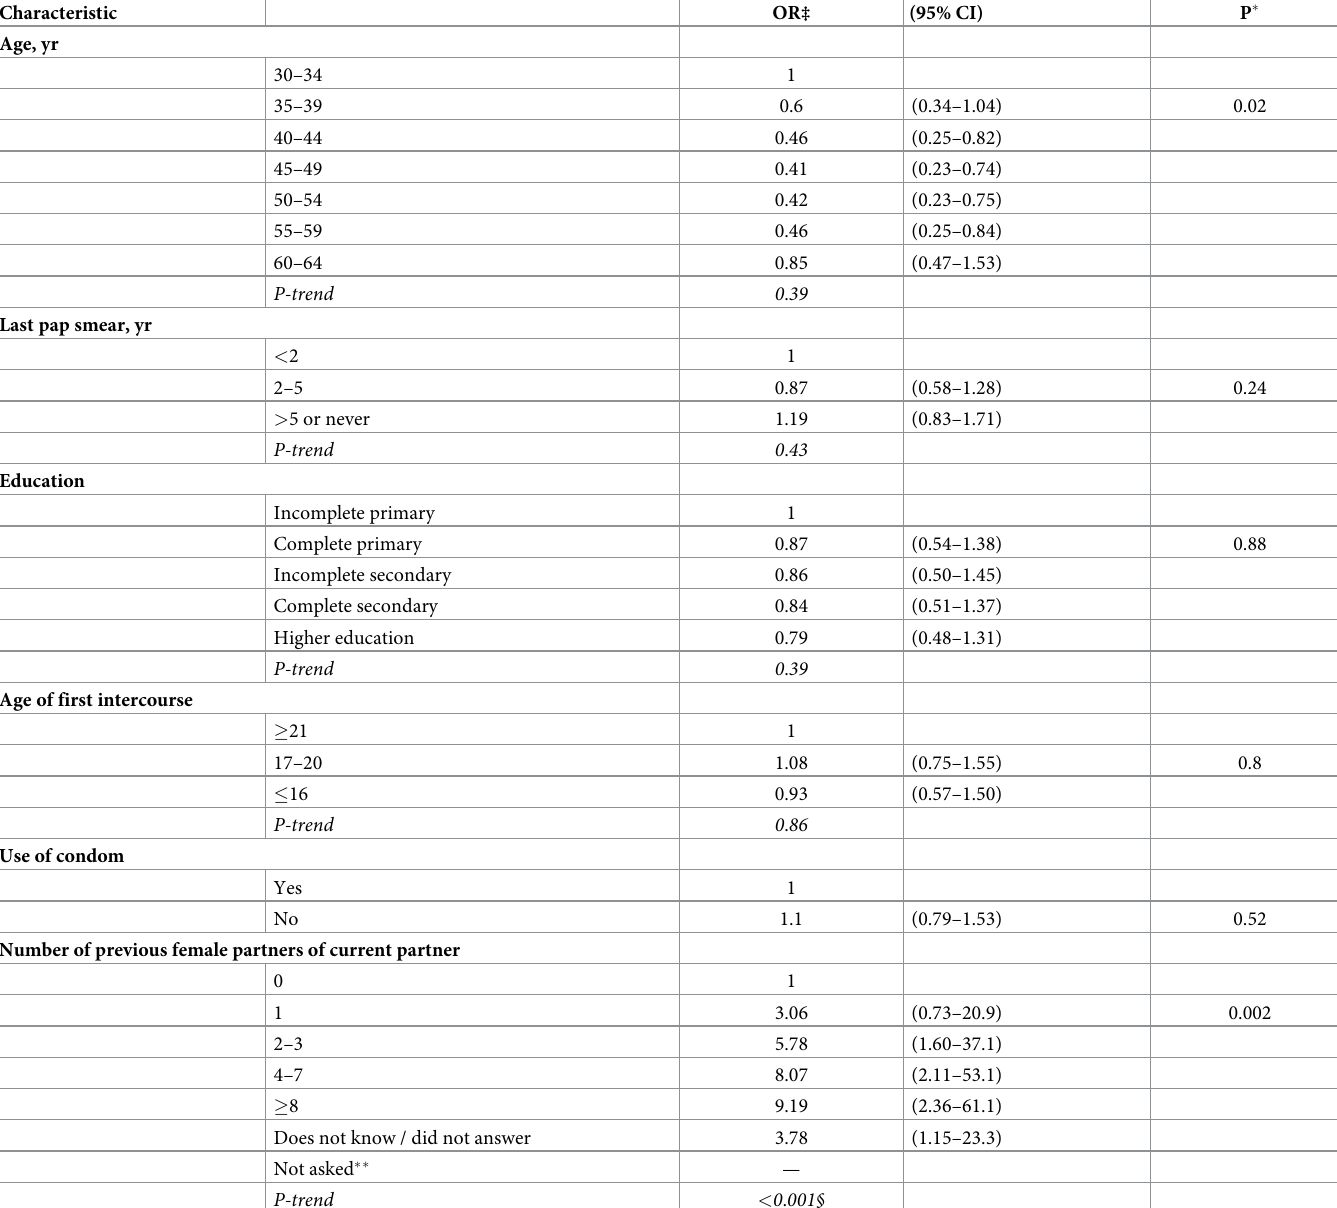
Table 4. Odds ratios of hrHPV infection associated with sociodemographic characteristics and selected risk factors among 30-69-year-old women with one lifetime sexual partner from the Central Department, Paraguay.